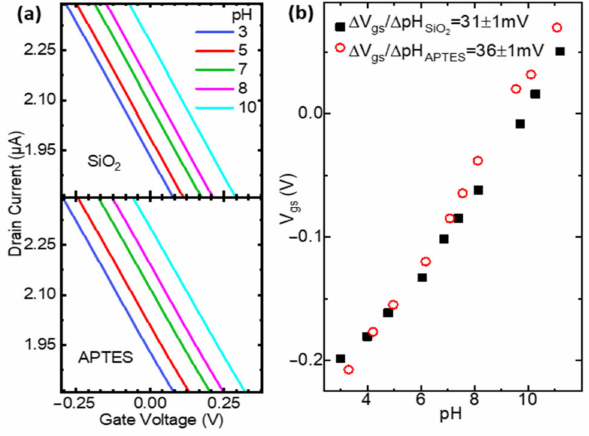
Figure 3. ( a ) Transfer I DS vs. V GS of a FinFET before (top) and after the APTES silanization process (bottom) with different pH (3, 5, 7, 8, 10) shown in different colors. ( b ) Scatter plot of V GS vs. pH before (black squares) and after the APTES silanization process (red open circles). The ∆ V GS / ∆ pH evaluated from the linear fit of the plots are indicated in the inset. For these measurements V DS was fixed at 300